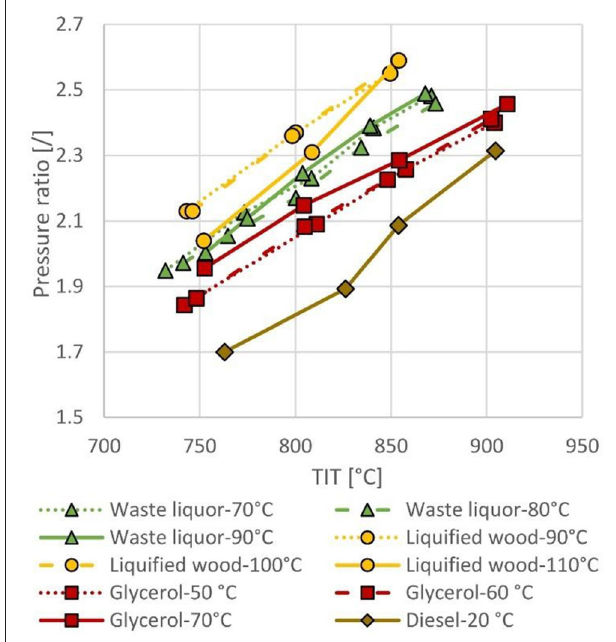
FIGURE 7 | Pressure